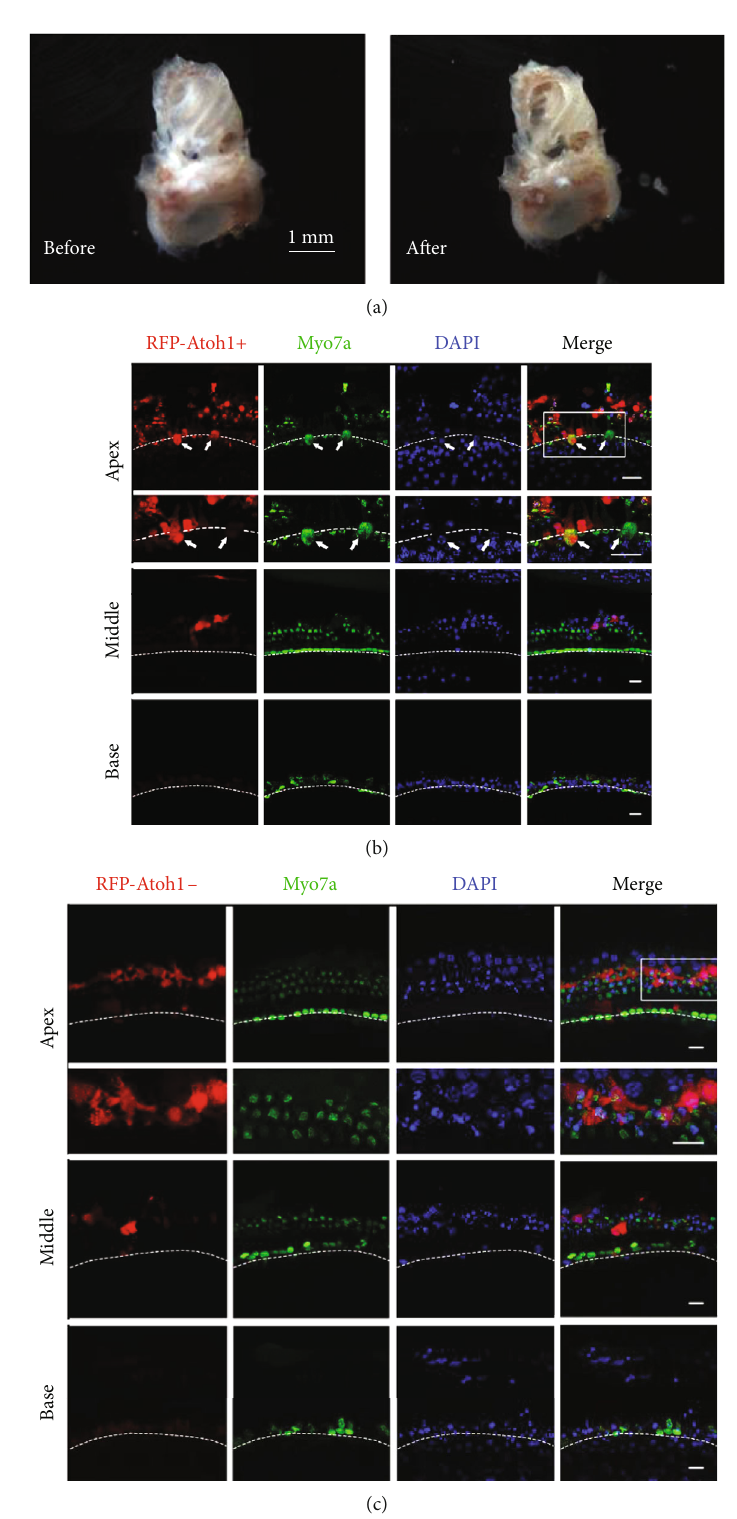
Figure 1: Atoh1 overexpression induces HCLC formation in the apical turn of adult mouse cochleae. (a) Establishment of adult cochlea explant cultures. A freshly dissected adult mouse cochlea with the intact bone (before) and with the holes perforated (after) before culture. (b, c) Infection status of RFP-Atoh1+ in apical (apex), middle (middle), and basal (base) turns of mouse cochleae at 3 DVI. HCLCs (arrows) were found in the IHC region of apical turn. Remnant myosin7a+ HCs appear shrunken and in a dying state. RFP-Atoh1- were used as controls. Scale bars: 1mm in (a), 15 μ m in (b) and (c). Rectangular boxes show areas from which high magni fi cation and dashed lines mark the IHC